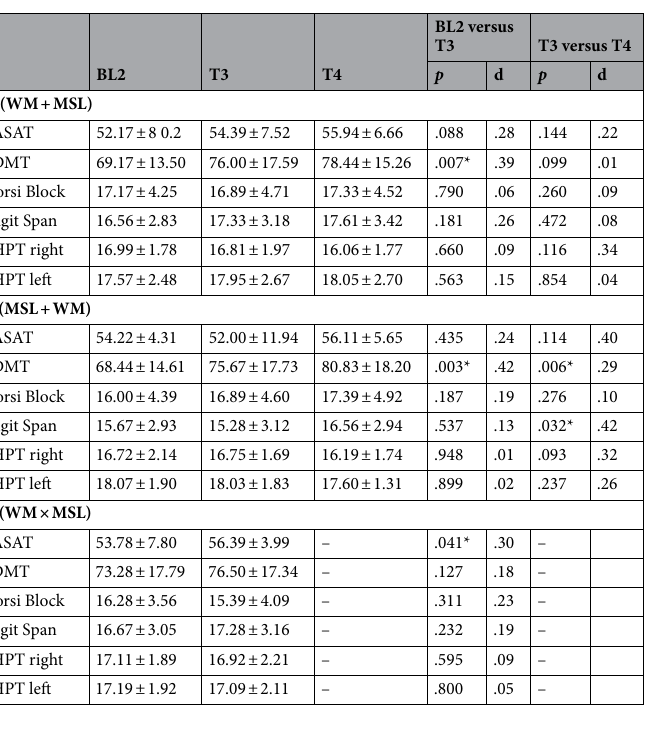
Table 4. Means, standard deviations and univariate comparisons of the neuropsychological assessment at each session for each group. For PASAT, SDMT, corsi block and digit span number of correct answers are displayed.